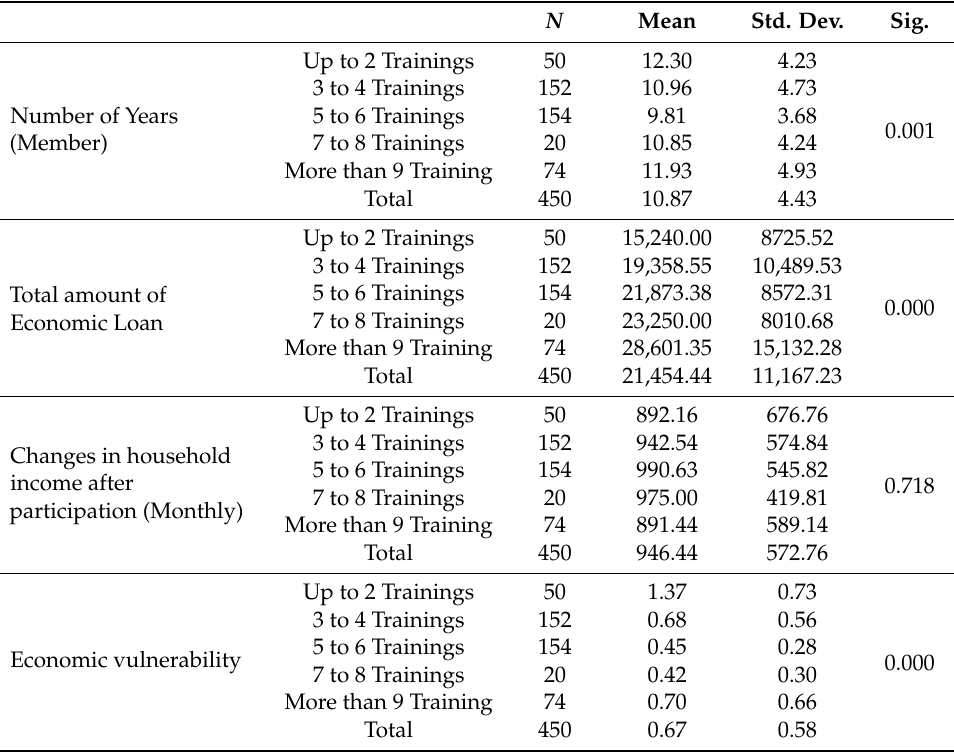
Table 4. Training and Key Determinants.